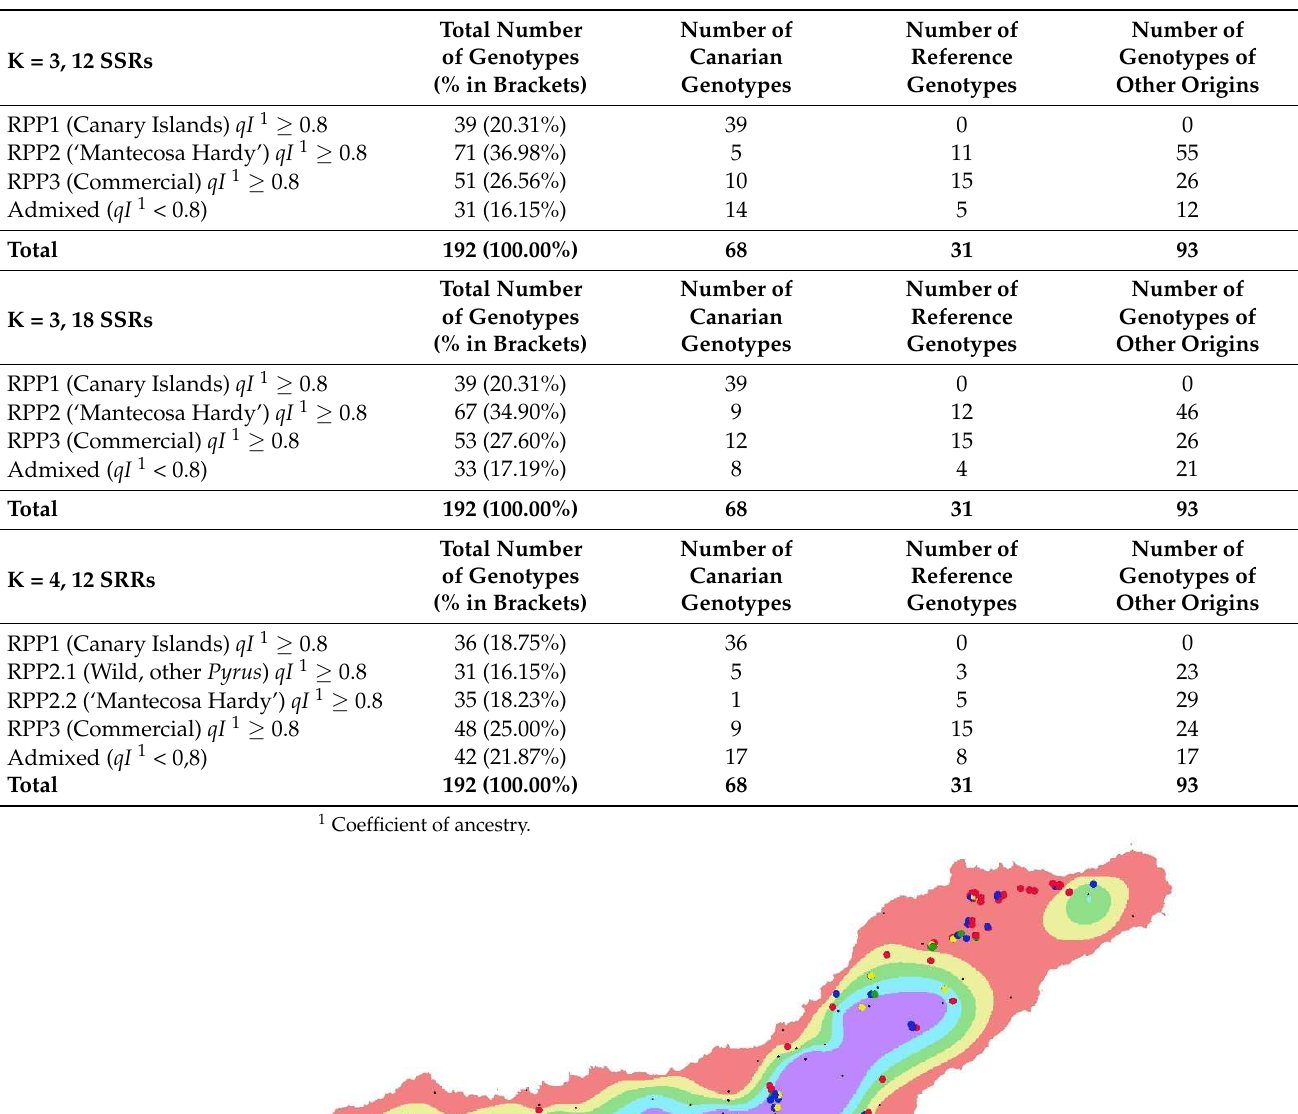
Table 3. Classification of 192 diploid pear genotypes for K = 3 and K = 4 reconstructed populations (RPPs) according to STRUCTURE [35] for the total study sample.